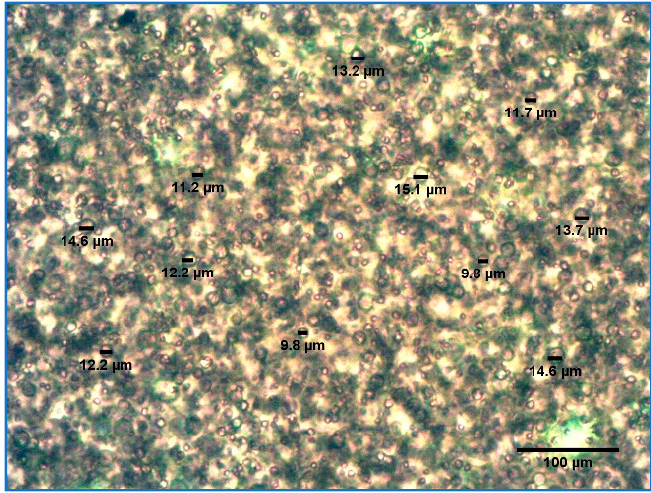
Figure 21. Sample S with 15% ( v / v ) water added. Dg average = 12.5 µm ± 0.01 .